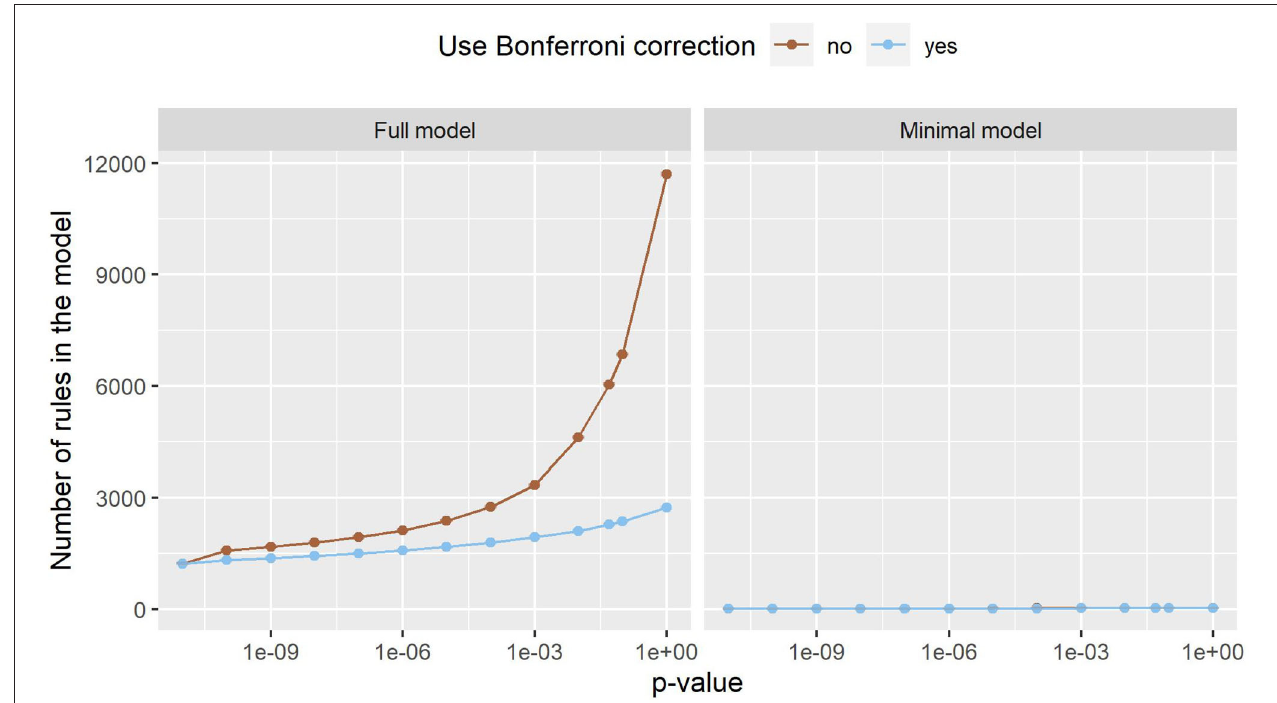
FIGURE 3 | The number of rules the full model (left) and the minimal model (right). Error bars (which are very small) show one standard deviation, the color indicates whether Bonferroni correction was used. The x-axis shows different p -values used in the filtering step. The leftmost dot denotes the p -value zero. The number of rules increases exponentially in the full model, while this effect is much smaller in the minimal model. The minimal model has fewer rules than the full